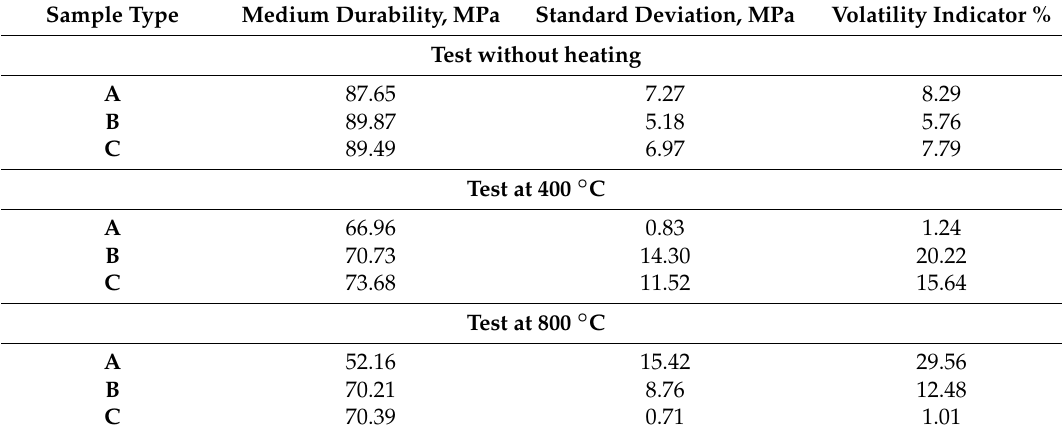
Table 4. Results of current research. Compressive strength of cylindrical